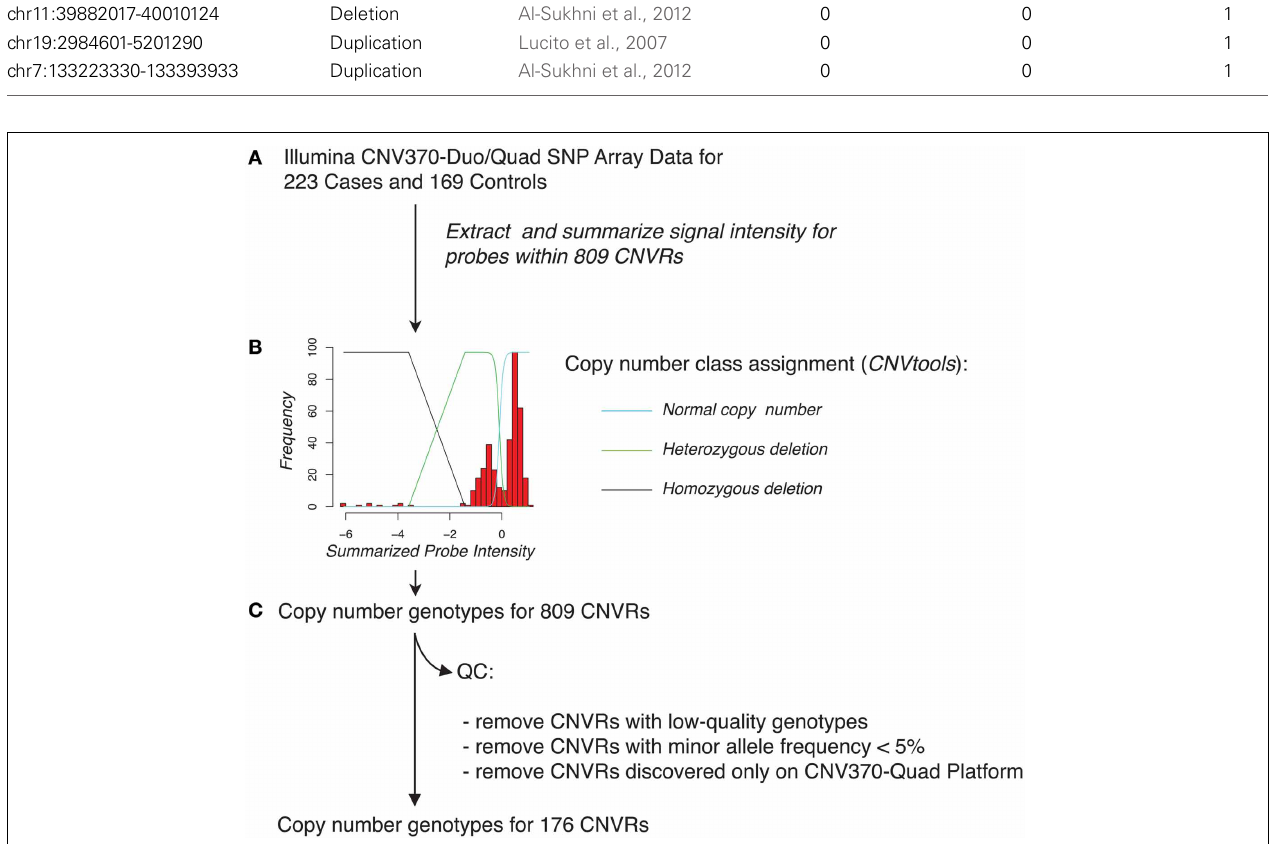
FIGURE 7 | Schematic overview of in silico genotyping of 809 CNVRs across pancreatic cancer cases and controls. (A) Using SNP array data for each of the 223 cases and 169 controls, we extracted signal intensity information for probes that overlapped with each of the CNVRs. Probe intensities for a given CNVR region were summarized on a sample-by-sample basis by taking the mean or by use of principal component analysis. (B) In silico genotyping for each CNVR was then performed using the CNVtools package, which assigns cases and controls to copy number classes by jointly